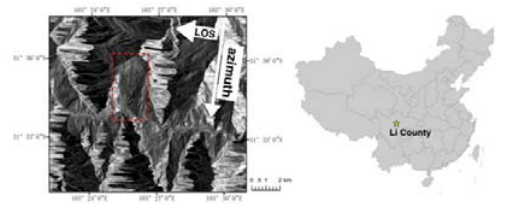
Figure 2. TerraSAR-X intensity image of Xishancun Landslide and Location of Li County in China